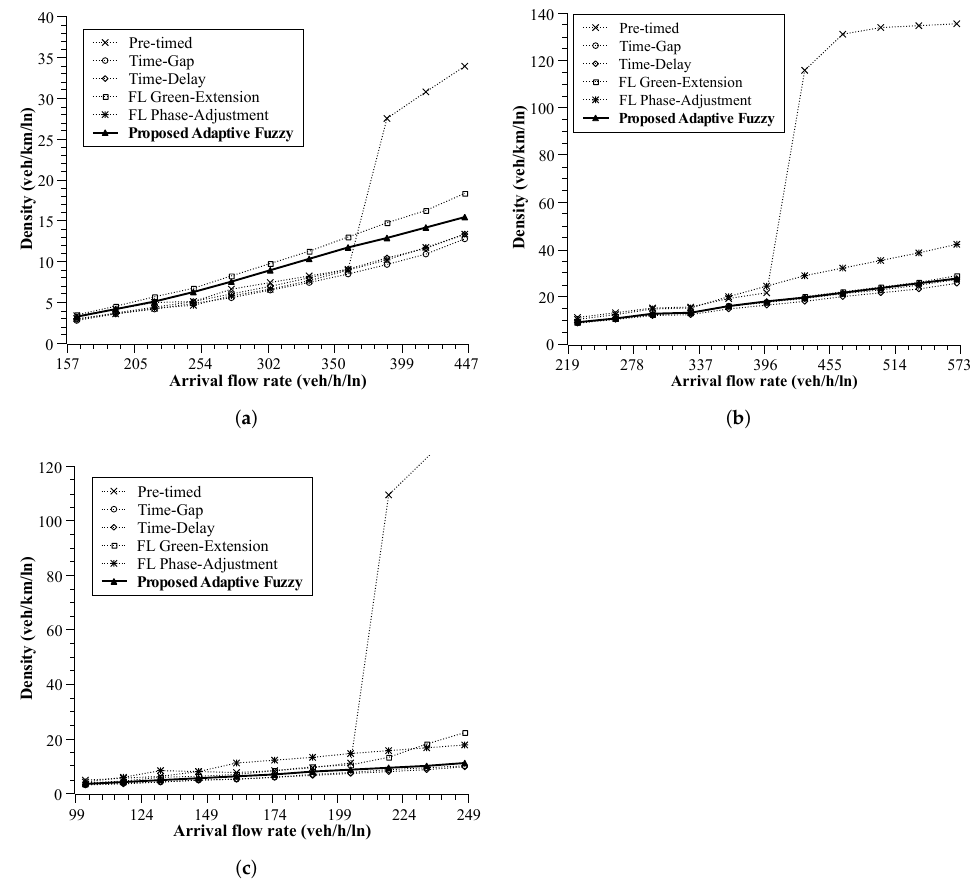
Figure 7. Traffic density as a function of the averaged system’s arrival flow rate: ( a ) stream A, ( b ) stream B, and ( c ) stream